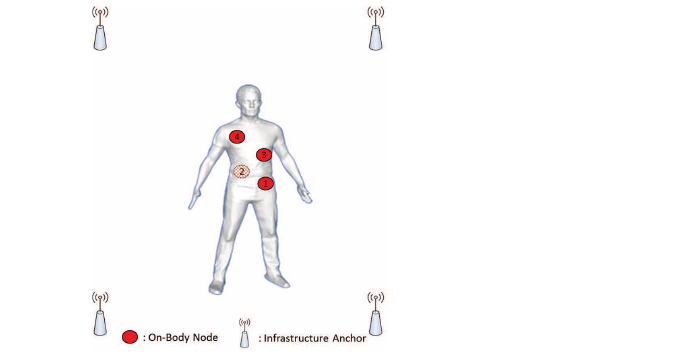
Figure 1. Typical WBSNs deployment scenario for individual